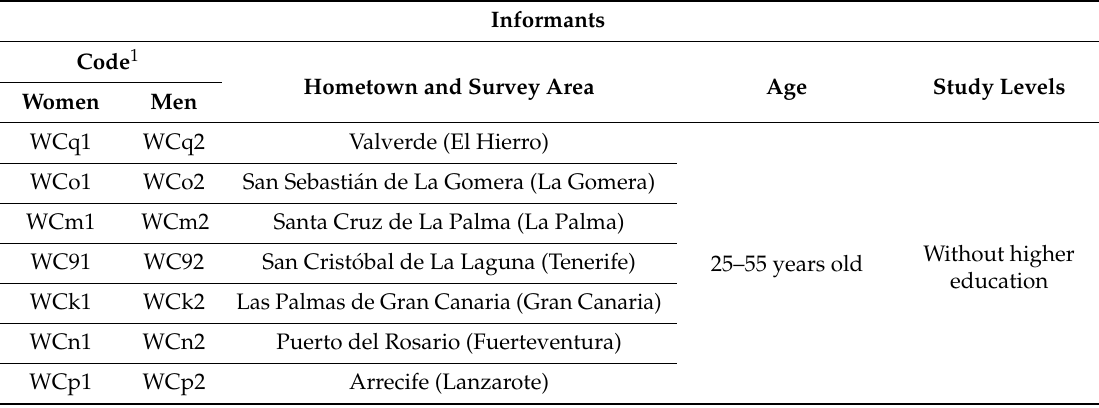
Table 1. Identification of the informants in the study.